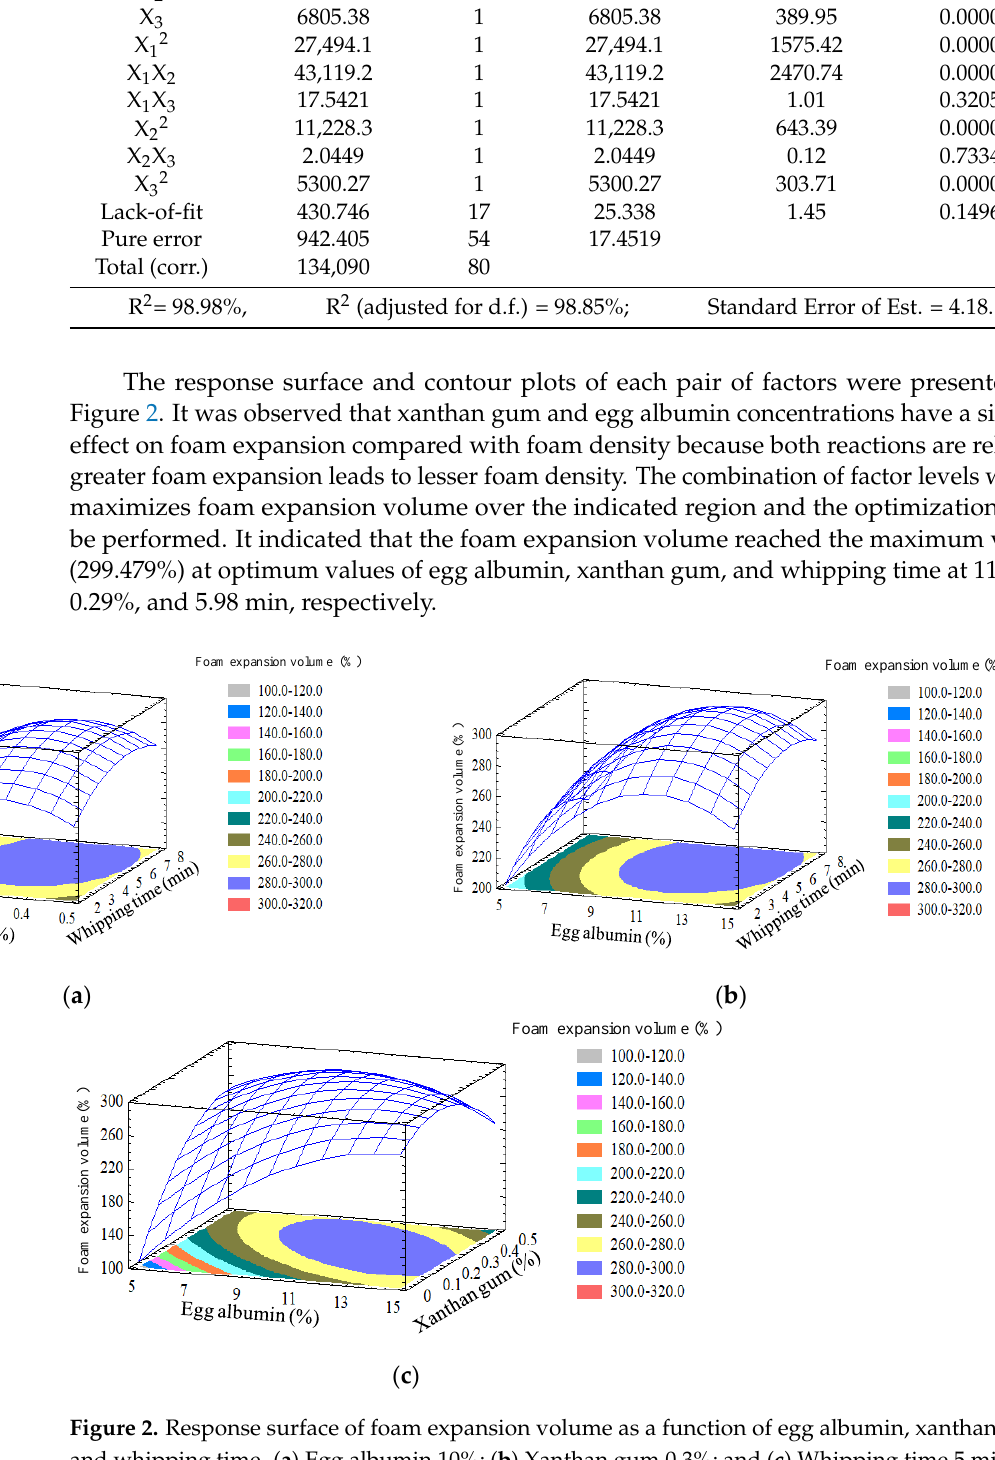
Figure 2. Response surface of foam expansion volume as a function of egg albumin, xanthan gum, and whipping time. ( a ) Egg albumin 10%; ( b ) Xanthan gum 0.3%; and ( c ) Whipping time 5 min. At the fixed egg albumin content of 10%, the foam expansion volume increased as the used concentration of gum xanthan and whipping time increased from 0.1 to 0.29% and 2 to 5.98 min, respectively (Figure 2a). However, when this optimal point is exceed-